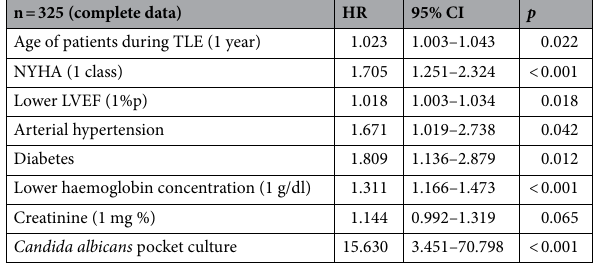
Table 3. Risk factors for deaths after TLE in PI patients. Results of multivariable stepwise Cox regression model. LVEF—Left ventricular ejection fraction; NYHA—New York Heart Association (class); PI—pocket infection; TLE—transvenous lead